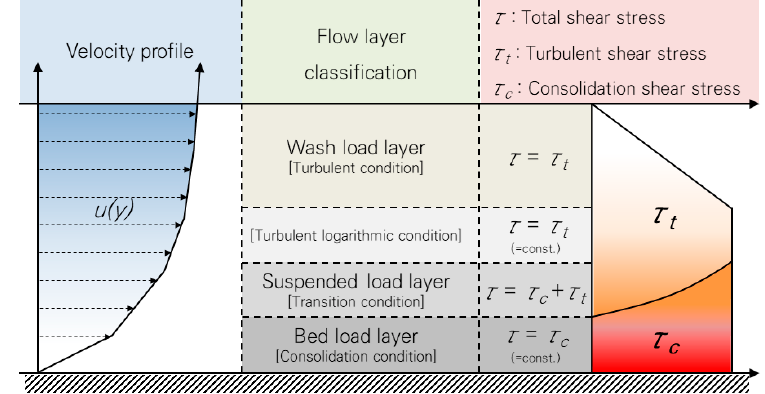
Figure 5. Classification of the flow layer according to shear stress characteristics.